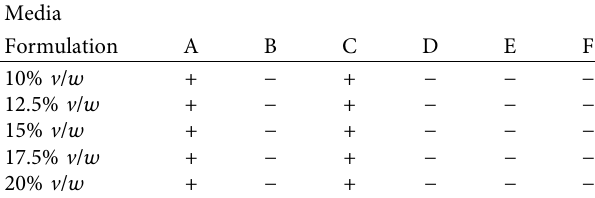
Table 4: Microbial loads of the formulated cream.